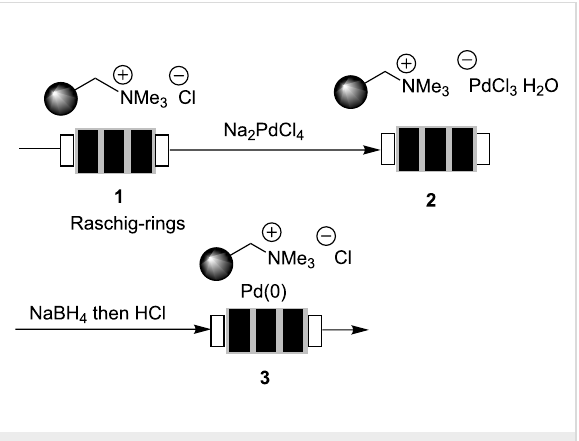
Scheme 1: Preparation of Pd(0) nanoparticles inside flow reactors.